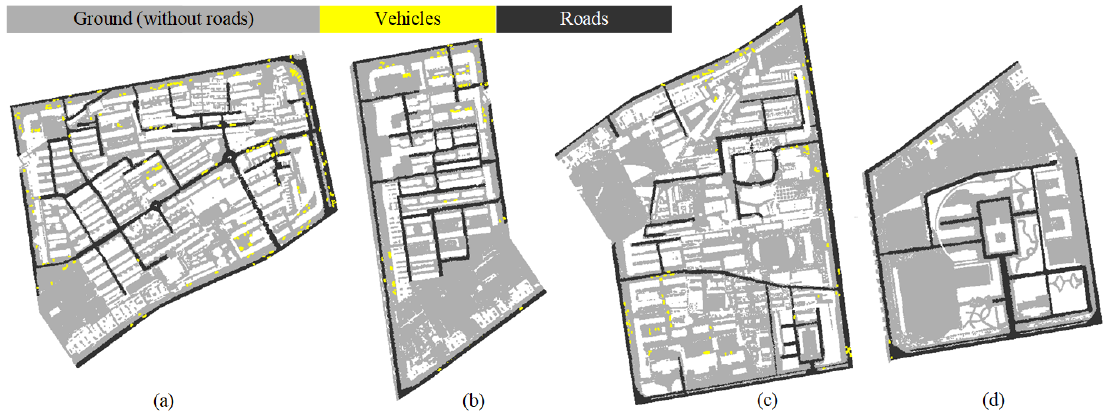
Figure 12. Annotated roads and vehicles in the datasets of ( a ) Section 1, ( b ) Section 2, ( c ) Section 3, and ( d ) Section